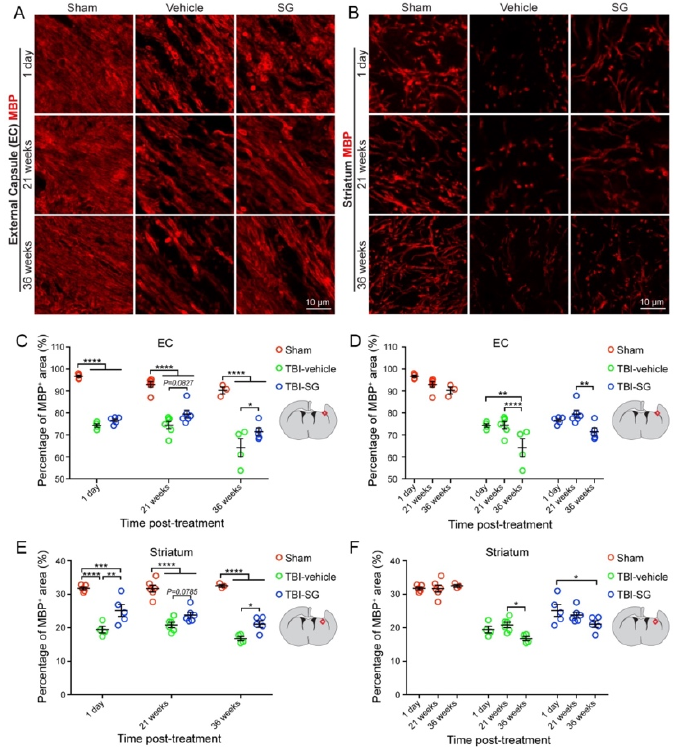
Figure 3. SCF+G-CSF treatment increases remyelination in the chronic phase of severe TBI. ( A , B ) Representative images of MBP immunopositive myelin in the ipsilateral external capsule ( A ) and striatum ( B ) at 1 day, 21 weeks, and 36 weeks post-treatment. ( C – F ) Quantitative data of analysis of the MBP immunopositive area in the ipsilateral external capsule ( C , D ) and striatum ( E , F ). Two-way ANOVA followed by Tukey post hoc test. * p < 0.05, ** p < 0.01, *** p < 0.001, * *** p < 0.0001. Scale bars: 10 µm. SG: SCF+G-CSF. EC: external capsule.